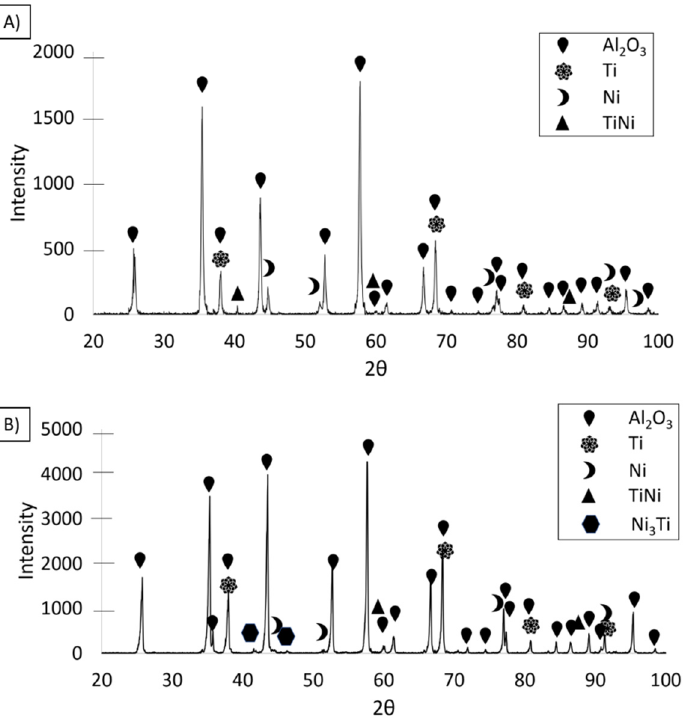
Figure 9. The phase composition of the sintered composite from ( A ) Series I, and ( B ) Series II.